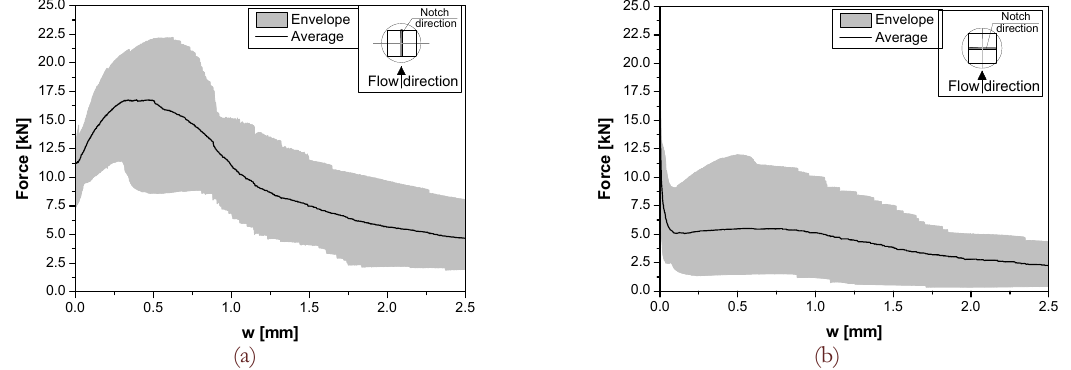
Figure 6: Force – average crack width relationship, F- w , obtained from the uniaxial tensile tests: (a) θ = 0 ° and (b) θ = 90 °